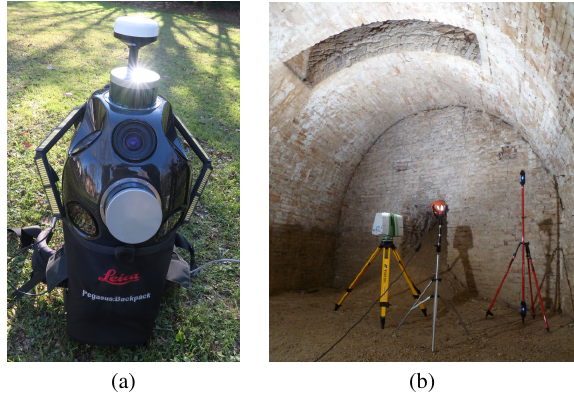
Figure 3. (a) Leica Pegasus backpack. (b) Setup of the Leica ScanStation C10 over a traverse mark and target pole over the back